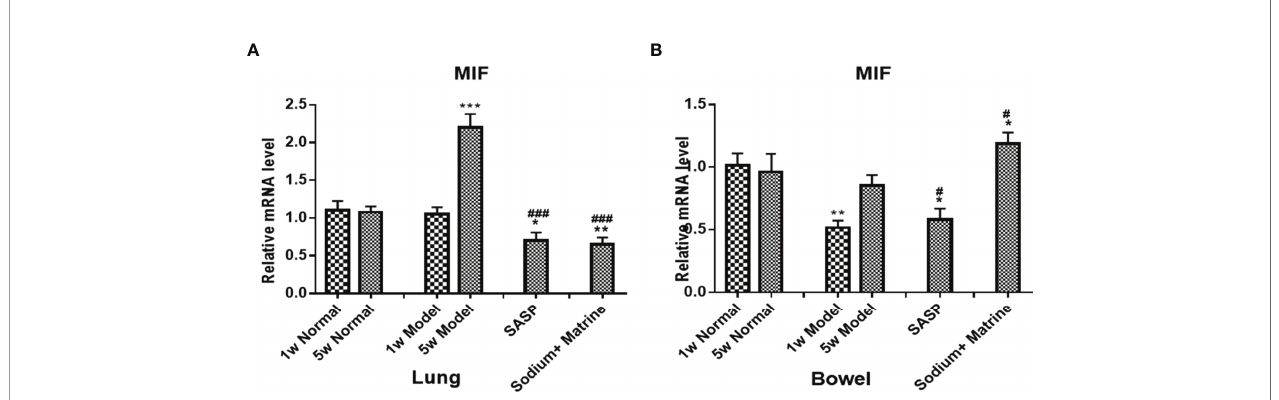
FIGURE 4 | Expression of MIF mRNA in the lung and bowel. UC models were established with the mucous membrane of colon allergize combine with TNBS- alcohol enteroclysis. MIF mRNA in the lung (A) and bowel (B) . Compared with Normal group, *P < 0.05; **P < 0.01; ***P < 0.001. Compared with model group, # P < 0.05, ### P